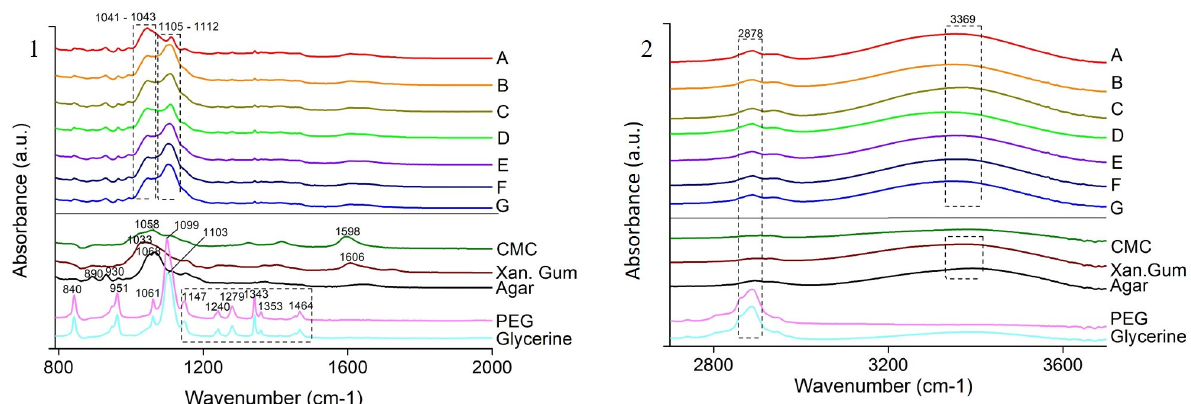
Figure 3. FTIR spectra of heat pressed films (A–G) and the individual components (CMC, Xanthan Gum, Agar, PEG and Glycerine) divided into two segments: ( 1 ) wavelength 800 to 2000 cm − 1 ( 2 ) wavelength 2000 to 4000 cm − 1 .